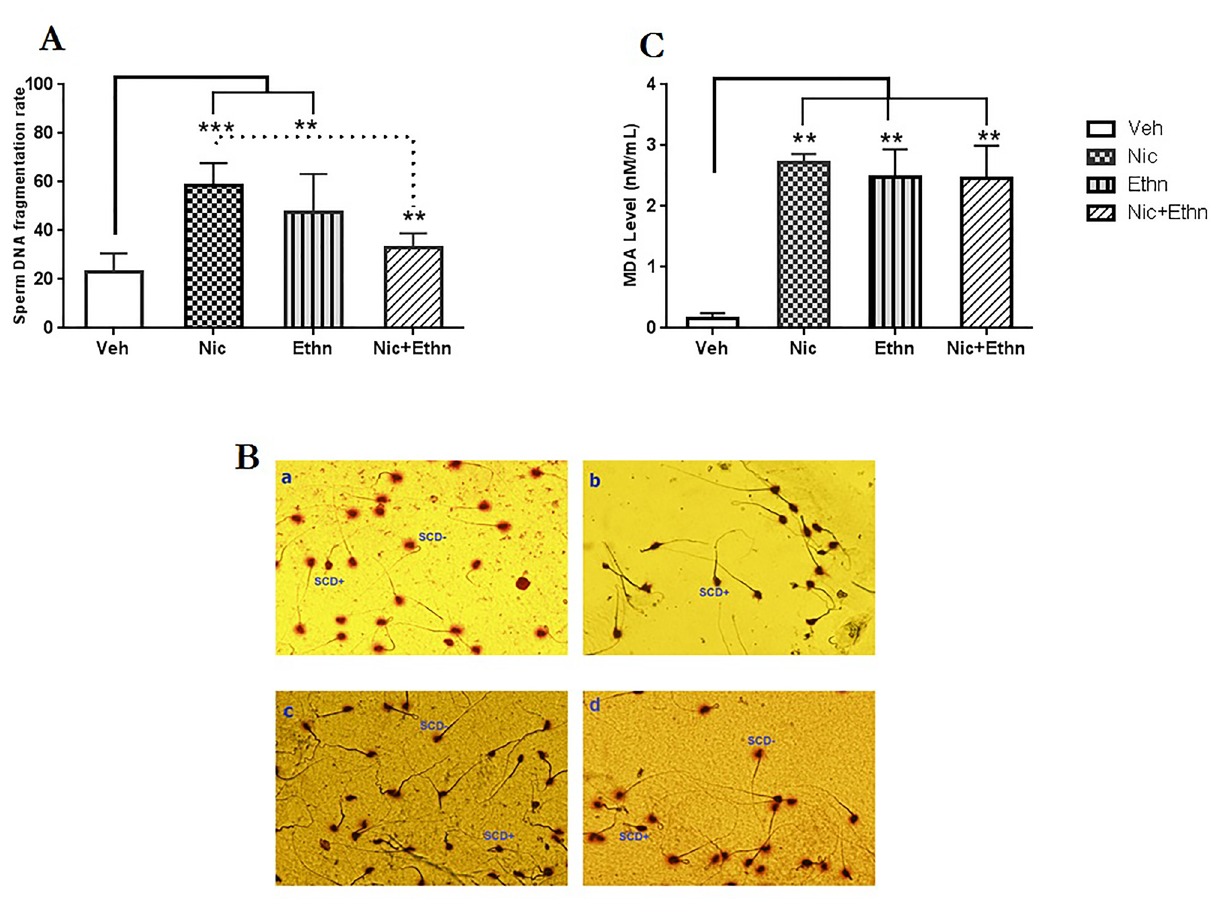
Figure 3. The effects of nicotine and ethanol exposure during embryofoetal development and breastfeeding periods on sperm DNA fragmentation (SDF). ( A ) SDF rate in different experimental groups. ( B ) SDF was assessed by sperm chromatin dispersion (SCD) test. SCD+ indicates sperm cells with fragmented DNA and SCD− indicates sperm cells with normal DNA integrity (×100 eyepiece magnification). Sperm cells of the vehicle ( a ), nicotine-exposed ( b ), ethanol-exposed ( c ) and concurrent exposed ( d ) animals. ( C ) Concentration of malondialdehyde (nmol/mL) in the serum of the mice that exposed to ethanol and nicotine, either alone or concurrently. ** and *** indicate p ≤ 0.01 and p ≤ 0. 001,